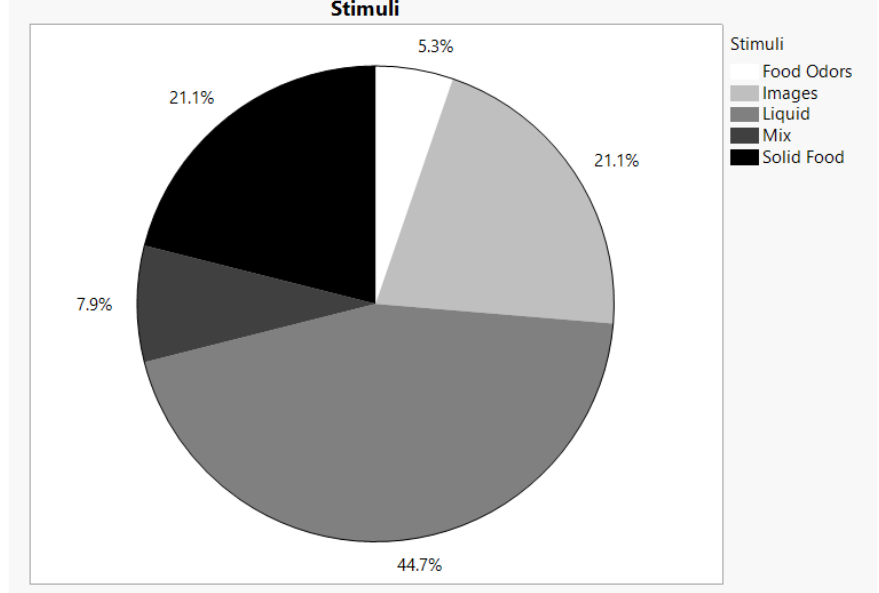
Figure 6. Stimuli utilized across the 38 studies related to AFEA, beverages, and/or packaging.